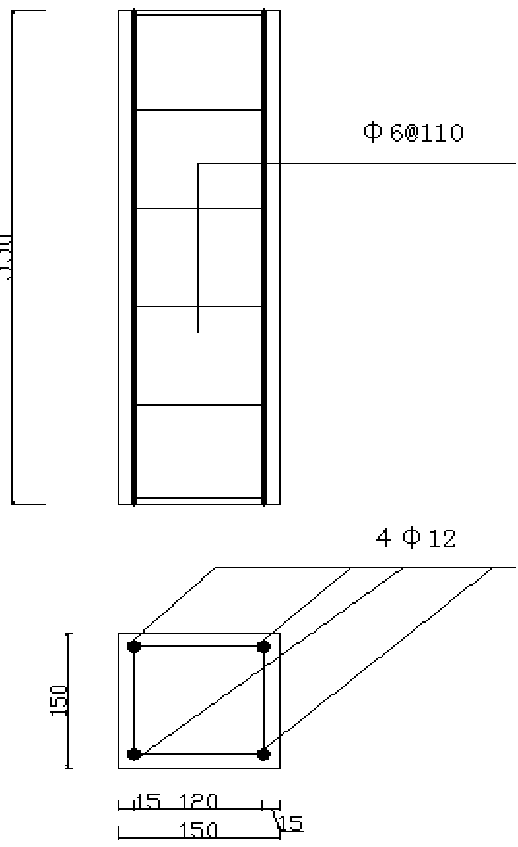
Figure 4. The structural dimension of the short column.